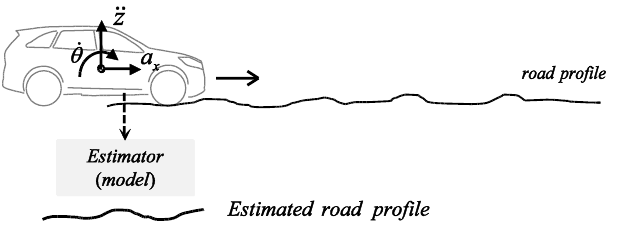
Figure 1. Concept of road profile estimation.